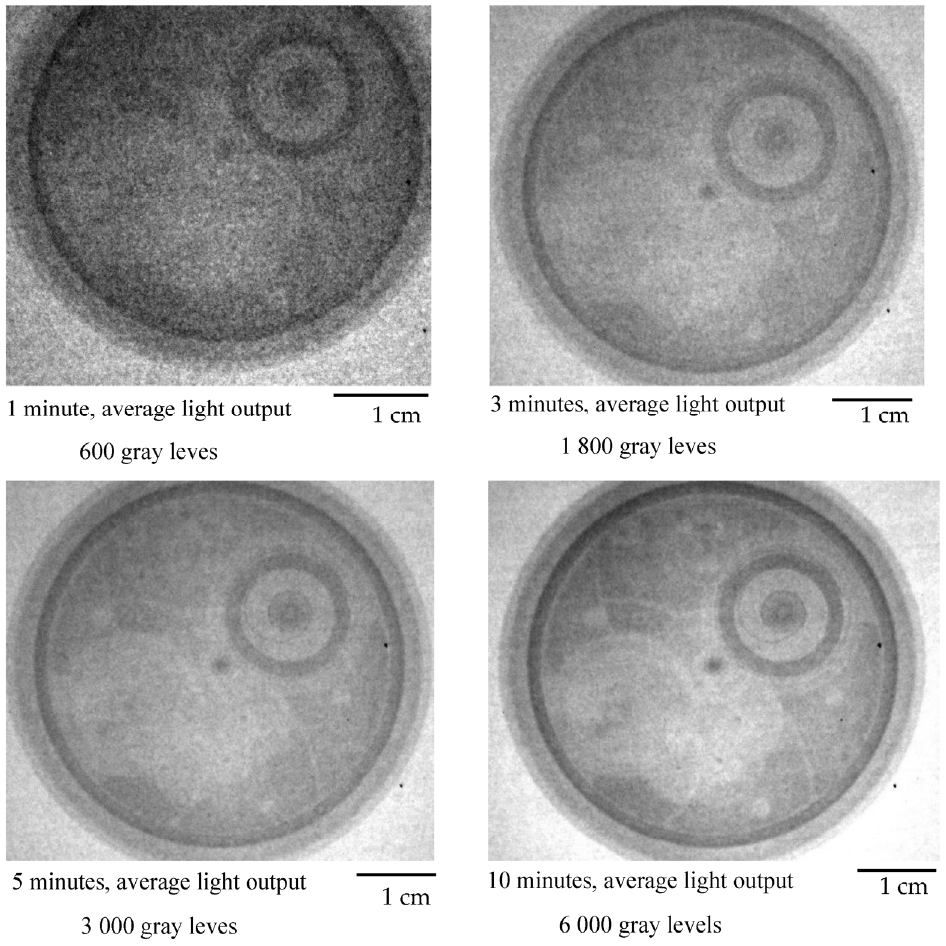
Figure 6. Neutron radiograph of a pocket watch at different exposure times (L/D = 20). Grayscales are stretched for optimal display.